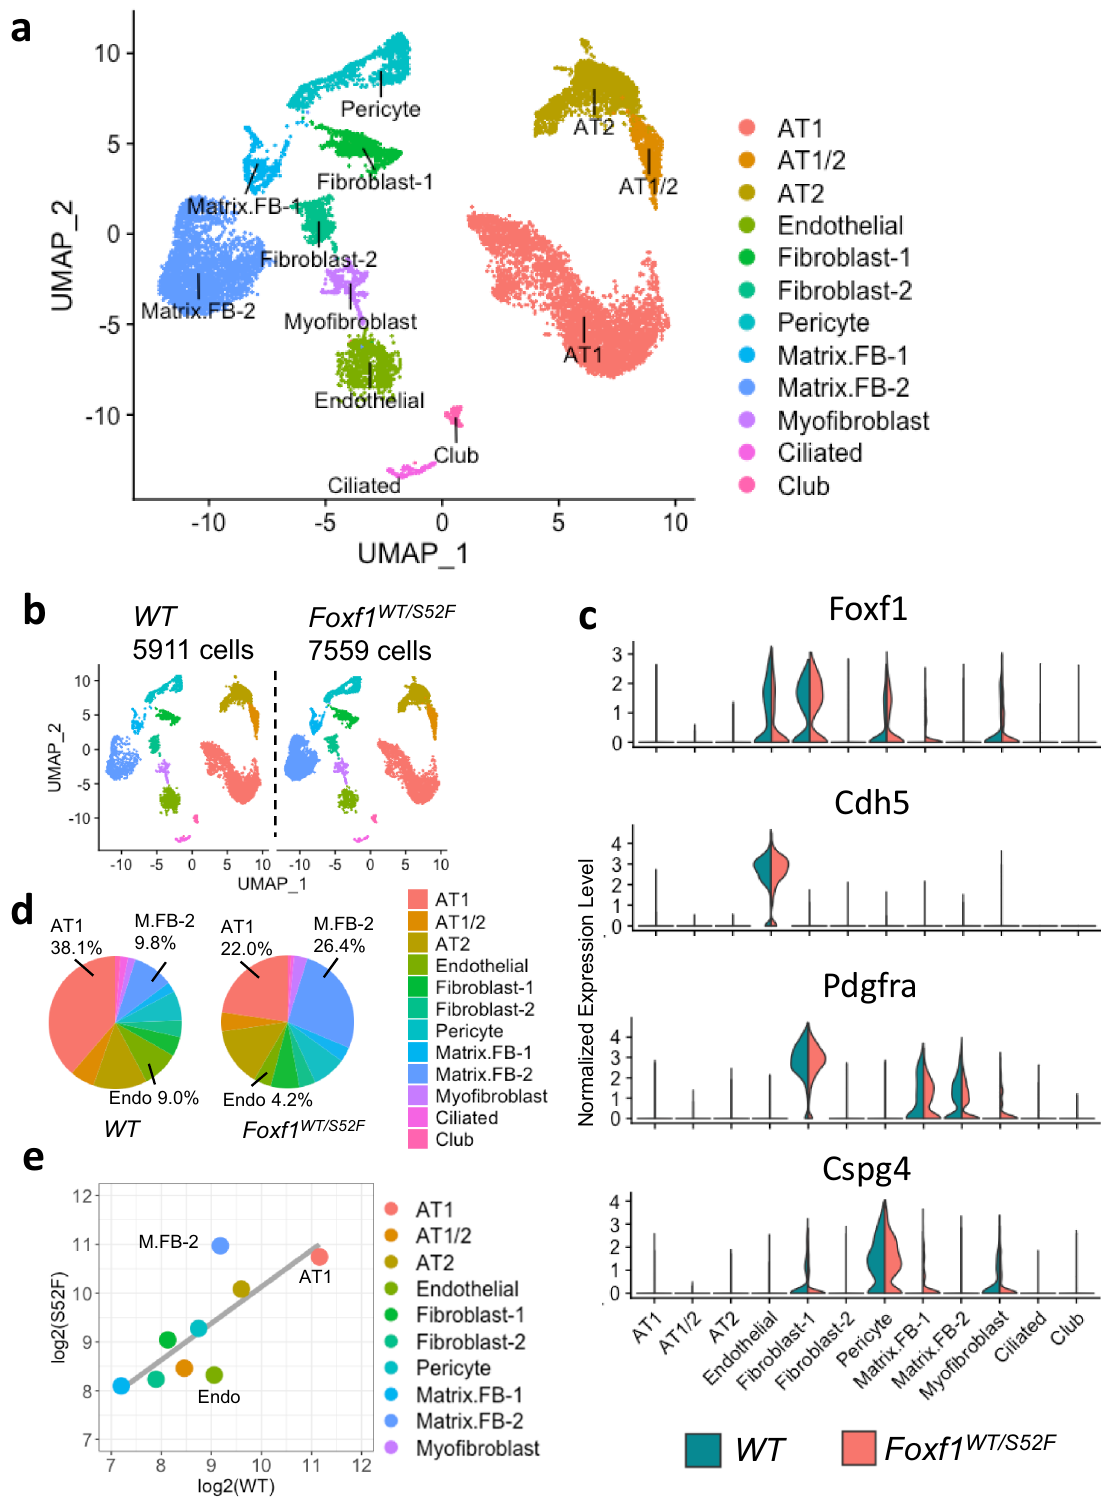
subdivided into 5 sub-clusters (Fig. 2a, and Supplementary Fig. 5a, b). These included arterial, venous, lymphatic, general capillary cells (gCAPs) and aerocytes (aCAPs). Foxf1 mRNA was mainly expressed in gCAPs and aCAPs (Fig. 2c, d). Foxf1 - expressing cells were also detected among arterial and venous clusters but were absent in the lymphatics (Fig. 2c).